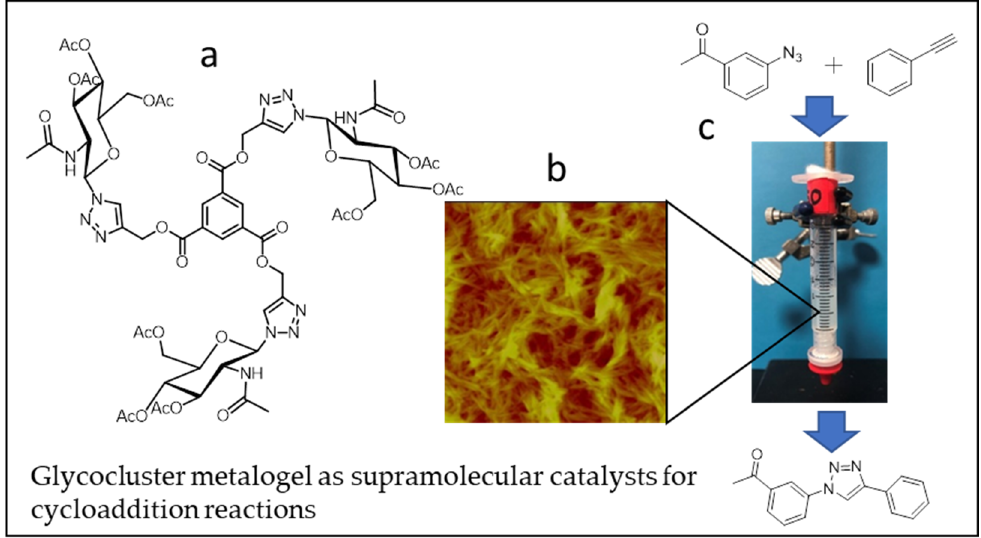
Figure 43. ( a ) Structure of the trimer glycocluster 66 ; ( b ) AFM image of the gel formed by 66 in 1:2 ethanol/water ( v / v ); ( c ) A copper metallogel column formed by 66 in 1:2 ethanol/water ( v / v ) was transferred to a syringe, which was used as a reaction vessel. This figure is adapted from [88] with modifications.